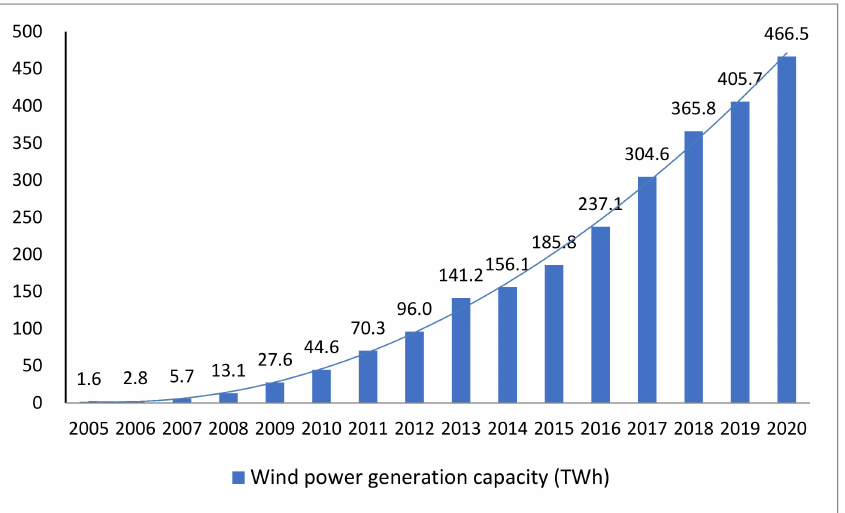
Figure 3. Trend of China’s wind power generation capacity. (Data source: National Bureau of